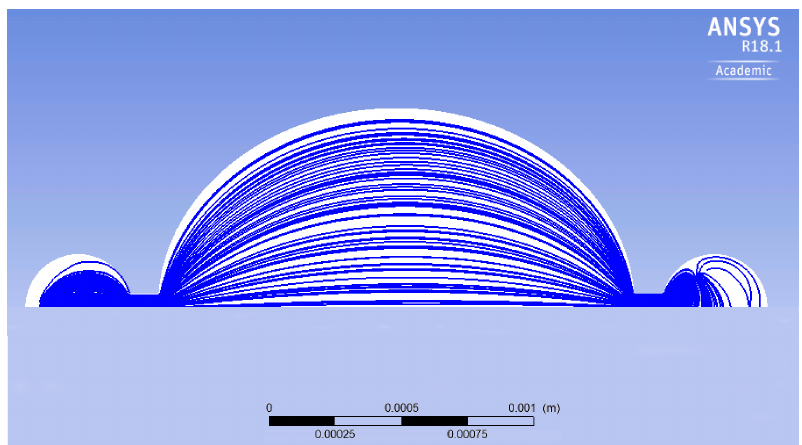
Figure 12. The streamlines in the elliptical geometry.